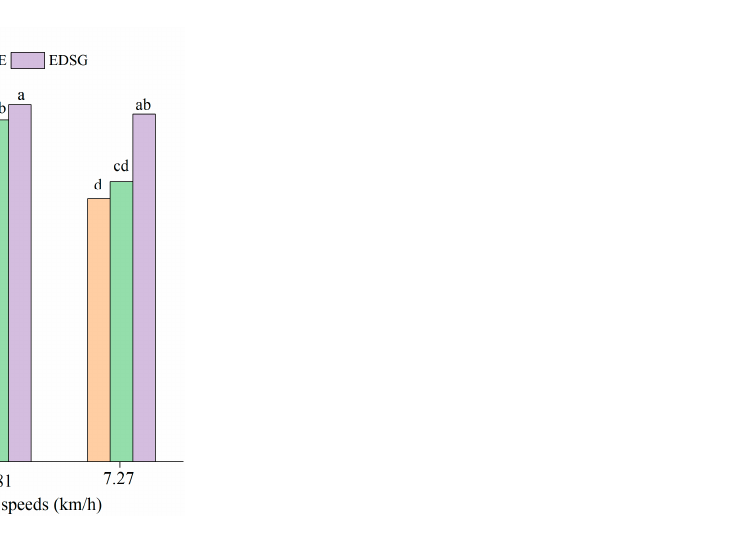
Figure 4. Mean seeding rates of MDS, EDSE, and EDSG at travel speeds of 4.62, 5.81, and 7.27 km·h − 1 . Different lowercase letters mean significant difference at the 0.05 level.